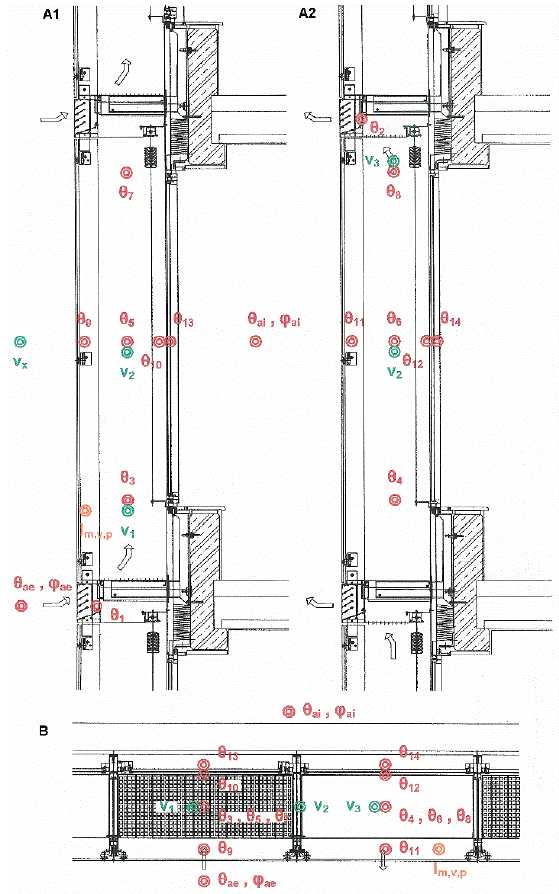
Figure 10: Examined physical parameters of the double skin trans- parent facade. A1 – vertical section – inlet module, A2 – vertical section – outlet module, B – horizontal section through inlet and outlet modules. Θ x – measuring points for temperature monitoring ( ∘ C), v x - measuring points for monitoring air velocity (m/s), ϕ a - measuring points for monitoring relative humidity (%) .